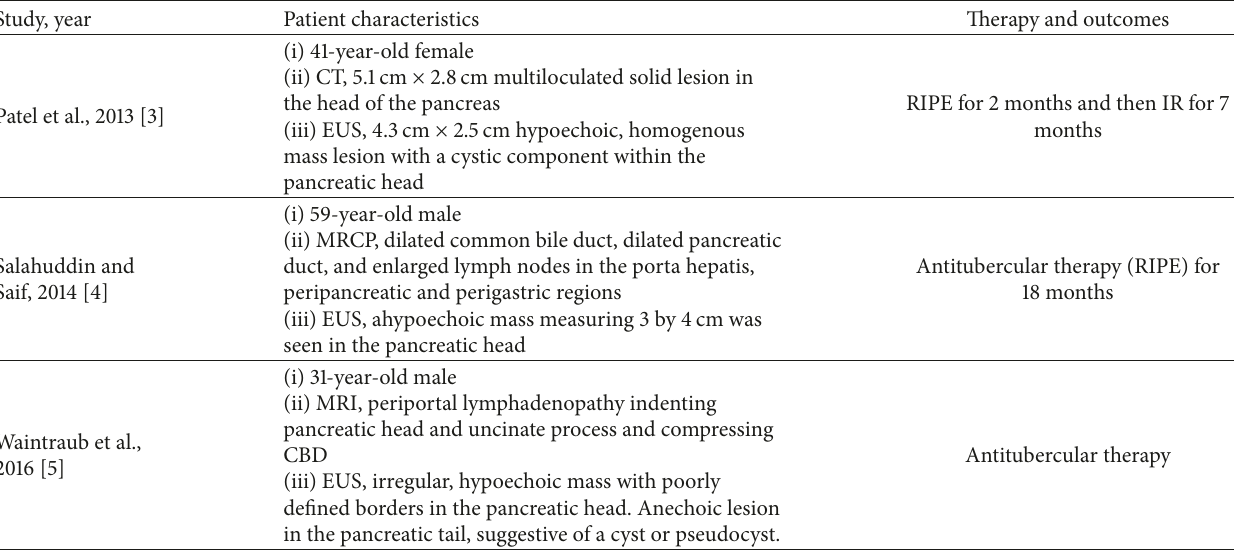
Table 1: It is showing cases of isolated pancreatic tuberculosis in the Western World along with the case characteristics and management strategies and outcomes over the last 5 years.